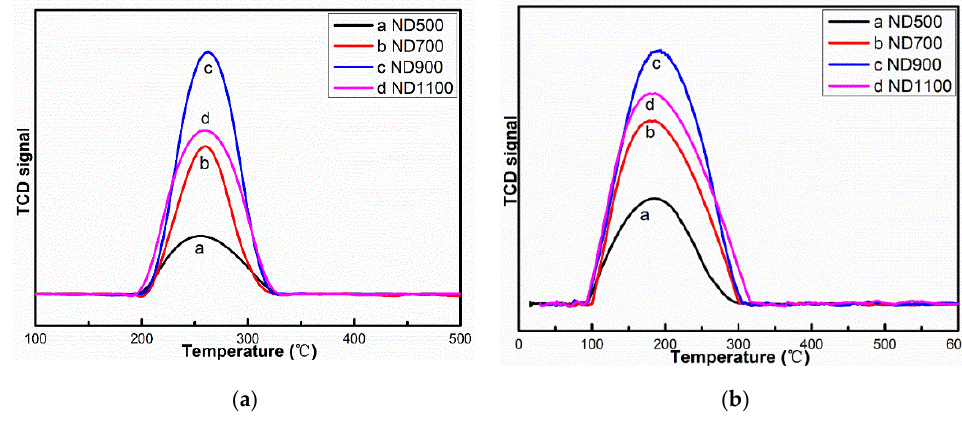
Figure 5. TPD evolution profiles of ( a ) acetylene and ( b ) hydrogen chloride.